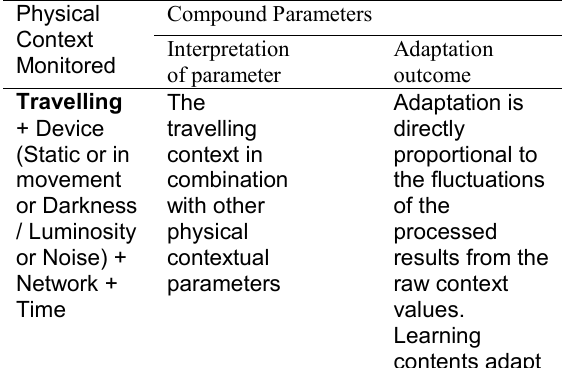
Table 3. Compound parameters tested –